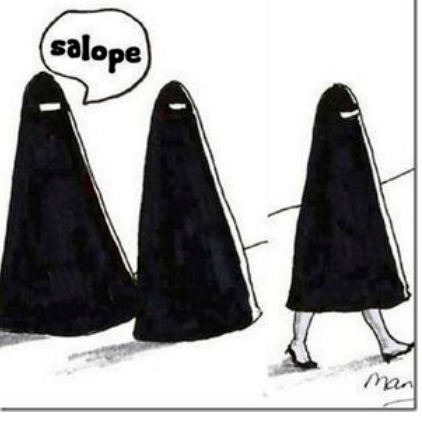
Figure 3. © man. Figure 3. ©